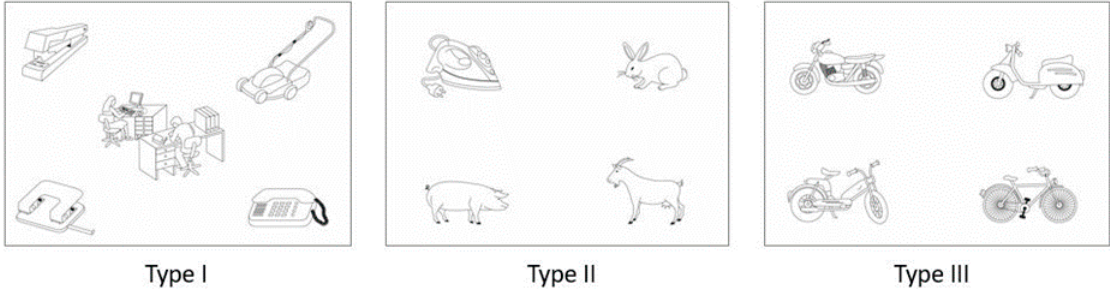
Figure A1. NVST subtest—Semantic Sorting: Examples of the three different task